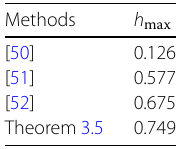
Table 6 Upper bound on h obtained for Example